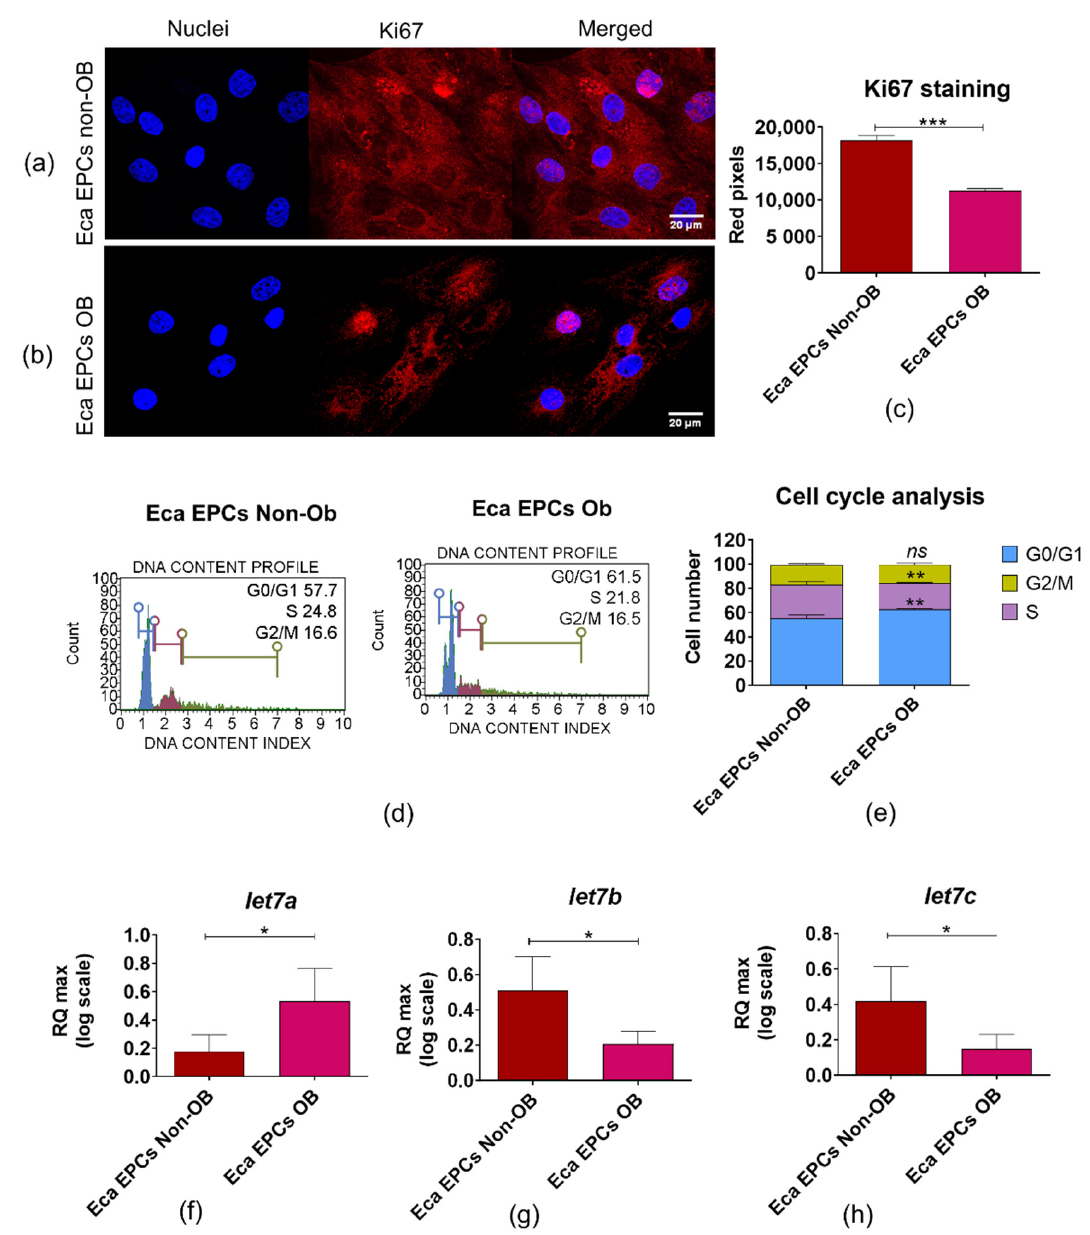
Figure 4. The proliferative capacity of equine endometrial progenitor cells (Eca EPCs) isolated from non-obese mares (non-OB) and obese mares (OB) evaluated based on Ki67 expression ( a – c ), distribution of cells within the cell cycle ( d – e ), and levels of particular let7 family members: let7a ( f ), let7b ( g ) and let7c ( h ). Columns with bars represent means ± SD. * p -value < 0.05, ** p -value < 0.01 and *** p -value < 0.001, while ns symbol refers to non-significant differences.